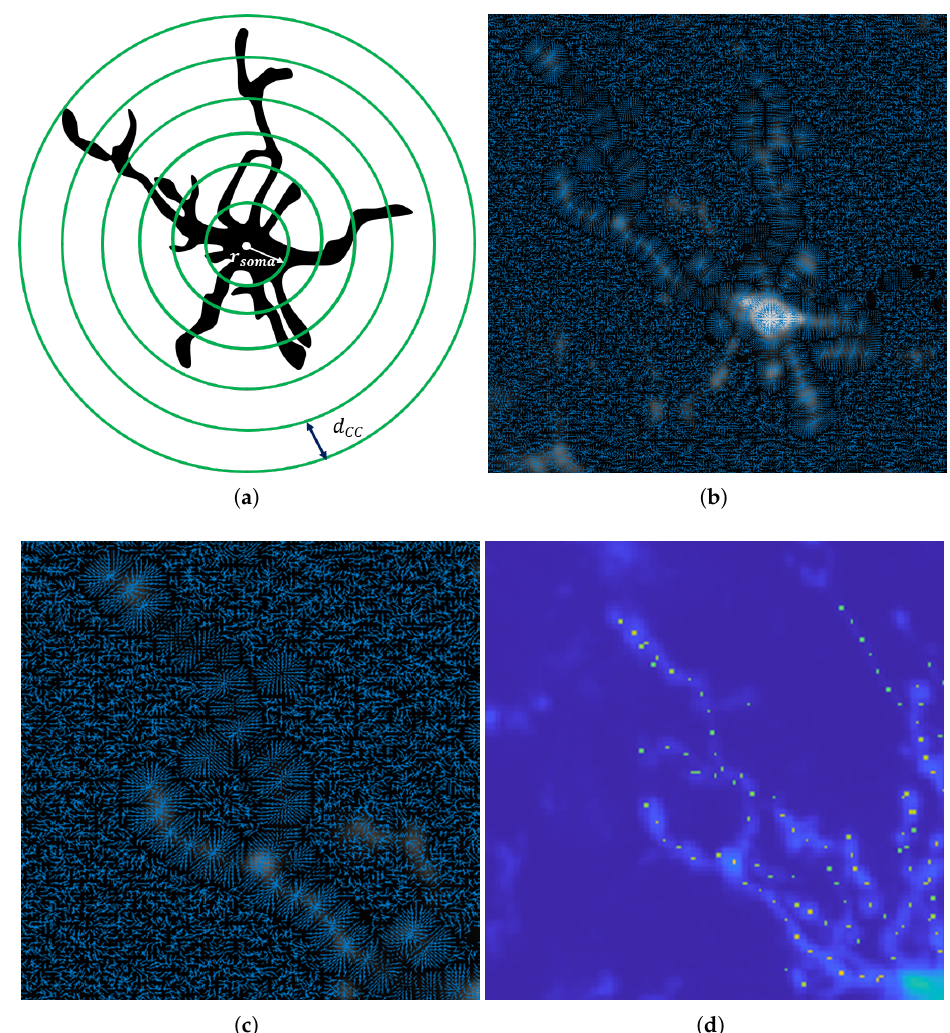
Figure 5. The VFC fields to find critical points of an object. ( a ) Concentric circles are placed around every detected soma to find ( b )the vector field of the intensity image on these circles ( c ) zoomed in ( d ) the critical points on the object of